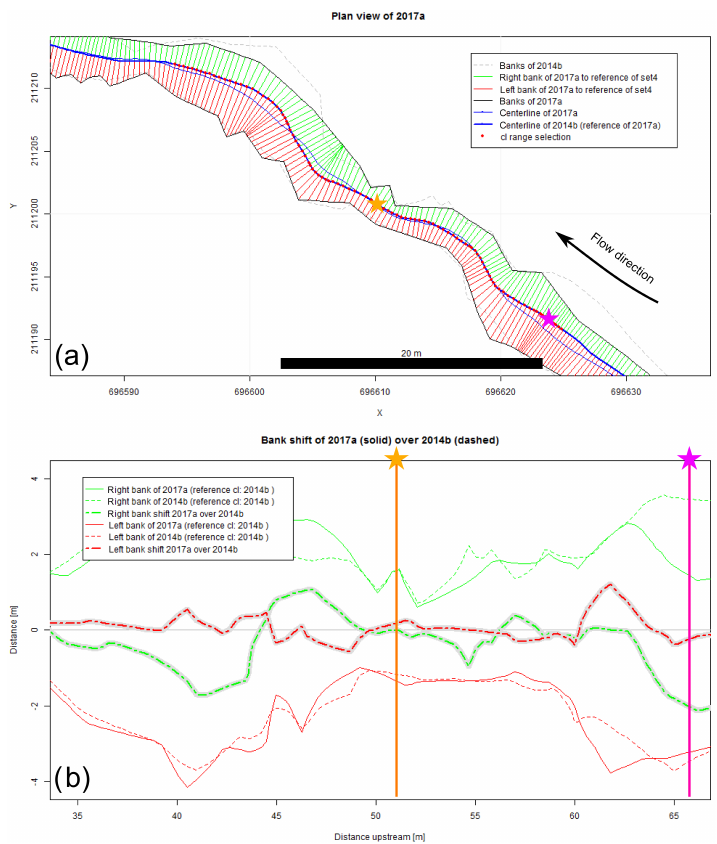
Figure 5. (a) Plan view of a short channel reach showing two channel surveys, 2014a (dashed channel outline) and 2017a (solid channel outline). A centerline is calculated for both, but due to an enabled reference mode, the centerline of 2014a is used for both surveys. This allows for the calculation of bank shift in panel (b) . The two stars mark two random locations to compare the calculated metrics to each other.